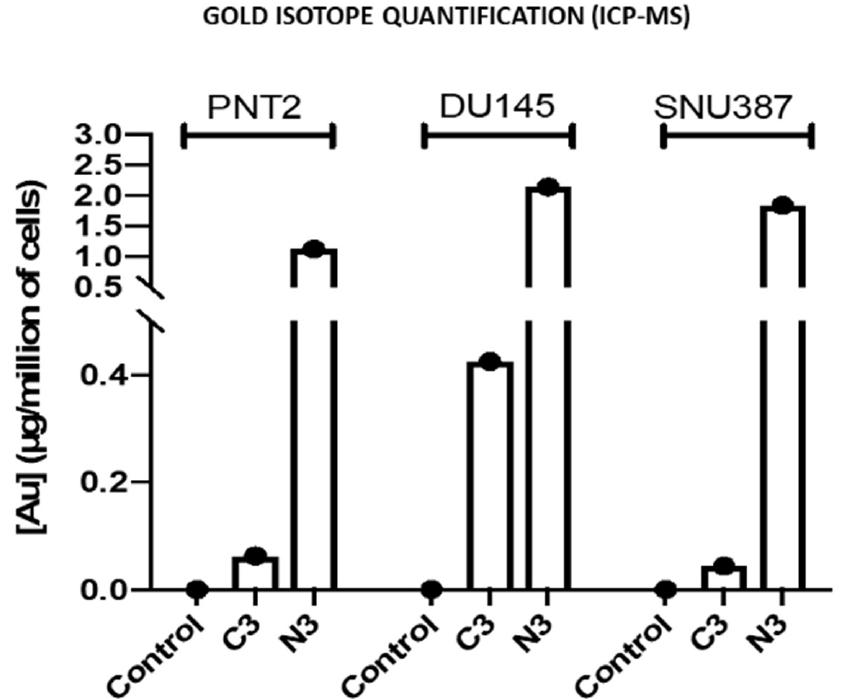
Figure 8. Representation of the concentration of Au isotopes by cell numbers, of the cell lines PNT2, DU145 and SNU 387, used as a validation model by means of an inductively coupled plasma mass spectrometry (ICP-MS) analysis. The data are mean values and the standard deviation (SD), respectively, is SD = 0.03, 0.2 and 0.0018 µ g/ million for C 3 , N 3 and Control in PNT2; SD = 0.04, 0.14, 0.06 µ g/million for C 3 , N 3 and Control in DU145; SD = 0.013, 0.015 and 0.03 µ g/million for C 3 , N 3 and Control in SNU387.